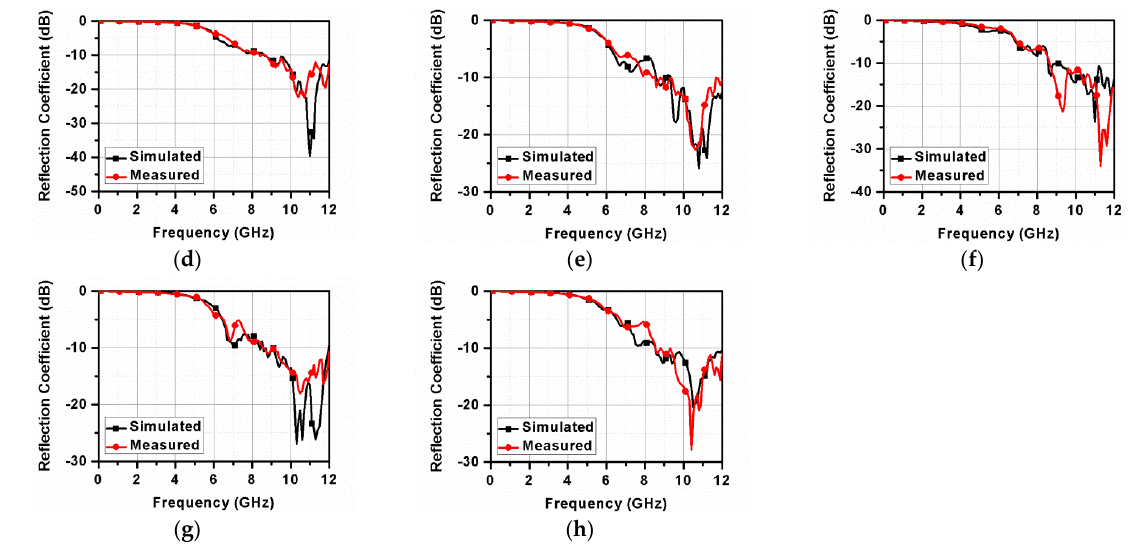
Figure 20. Plot of ( a ) S 18 18, ( b ) S 19 19, ( c ) S 20 20, ( d ) S 21 21, ( e ) S 22 22, ( f ) S 23 23, ( g ) S 24 24, ( h ) S 25 25.